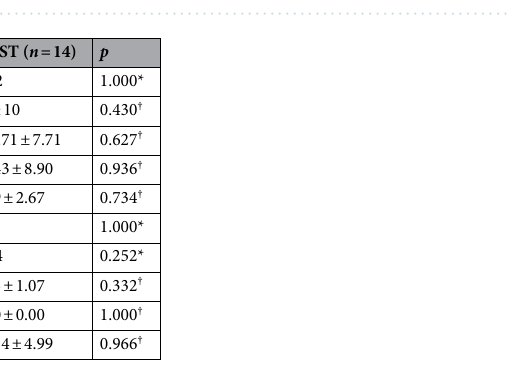
Table 2. Demographic and clinical characteristics of the participants. E-RAGT , end-effector robot-assisted gait training, BWST bodyweight-supported treadmill training, FAC functional ambulation category, BBS Berg Balance Scale. * χ 2 test, † t -test. a Number, b Mean ± standard deviation.